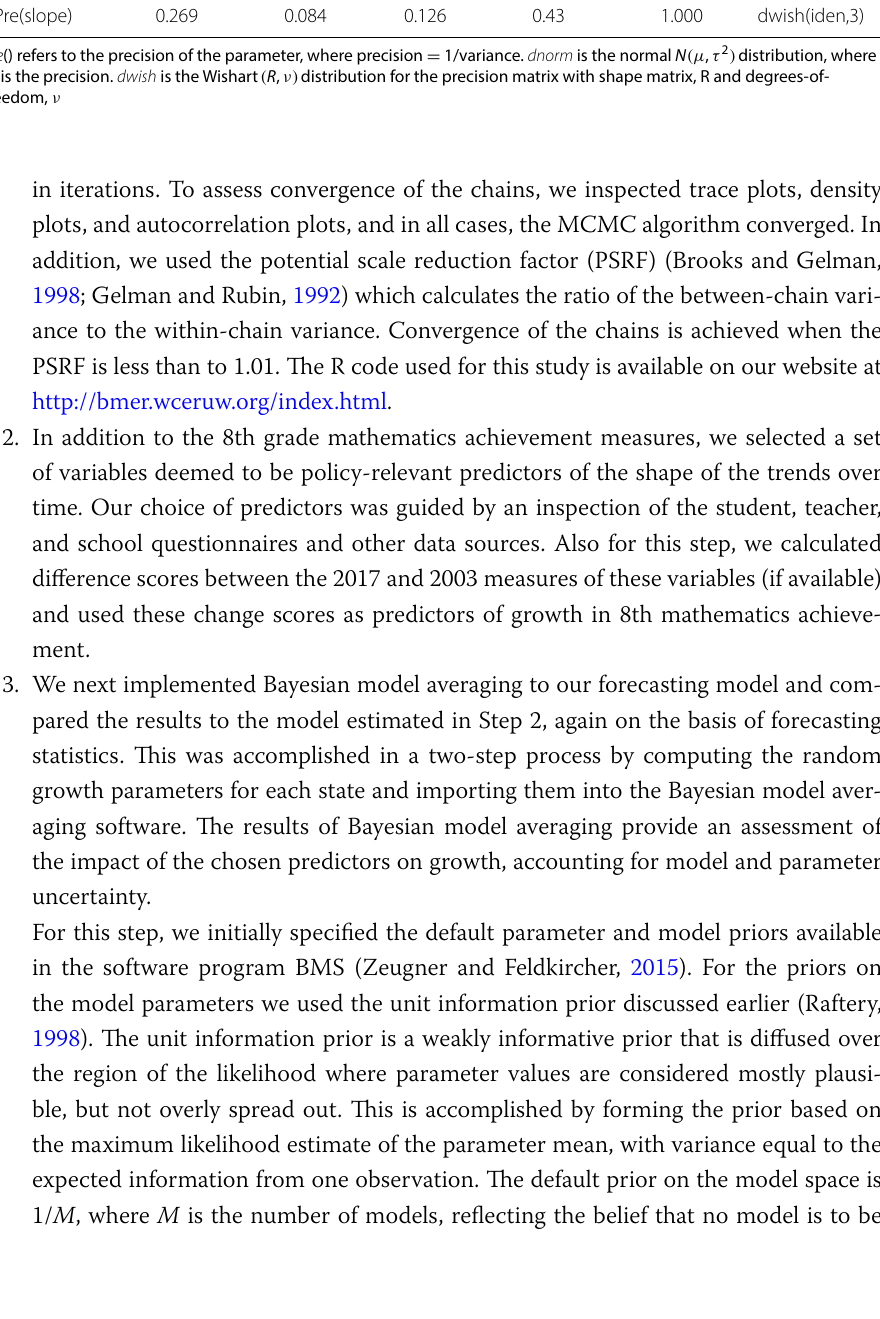
Pre(slope) 0.246 0.067 0.132 0.385 1.000 dwish(iden,3) Girls growth params.